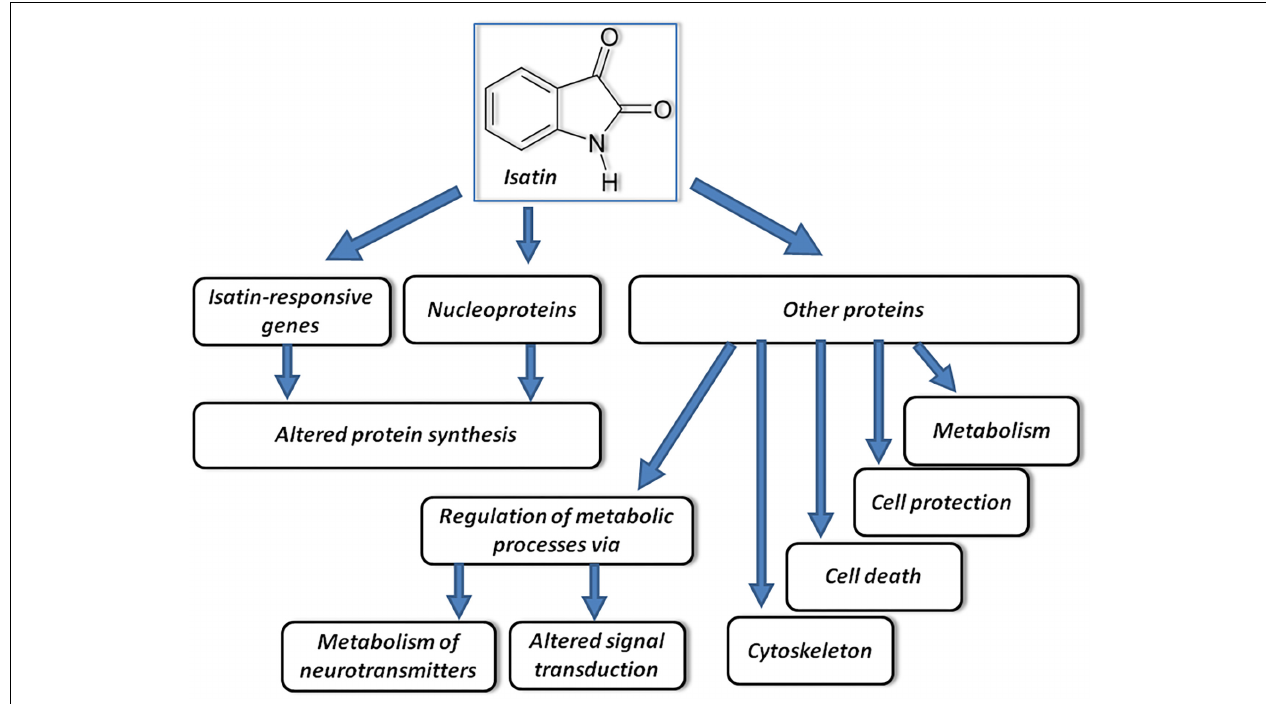
FIGURE 1 | Proposed mechanisms of multitarget effects of isatin. Acting on responsive genes and certain nucleoproteins, isatin influences synthesis of proteins. Acting on other protein targets, it influences other processes schematically shown on the figure and considered in the text. Modified from Medvedev et al.